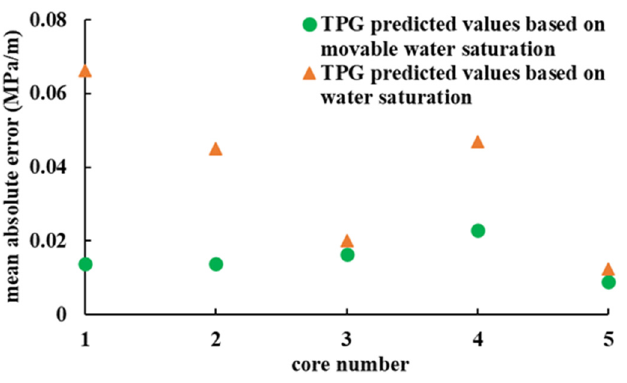
Figure 11. Mean absolute errors between experimental values and predicted values of the TPG.